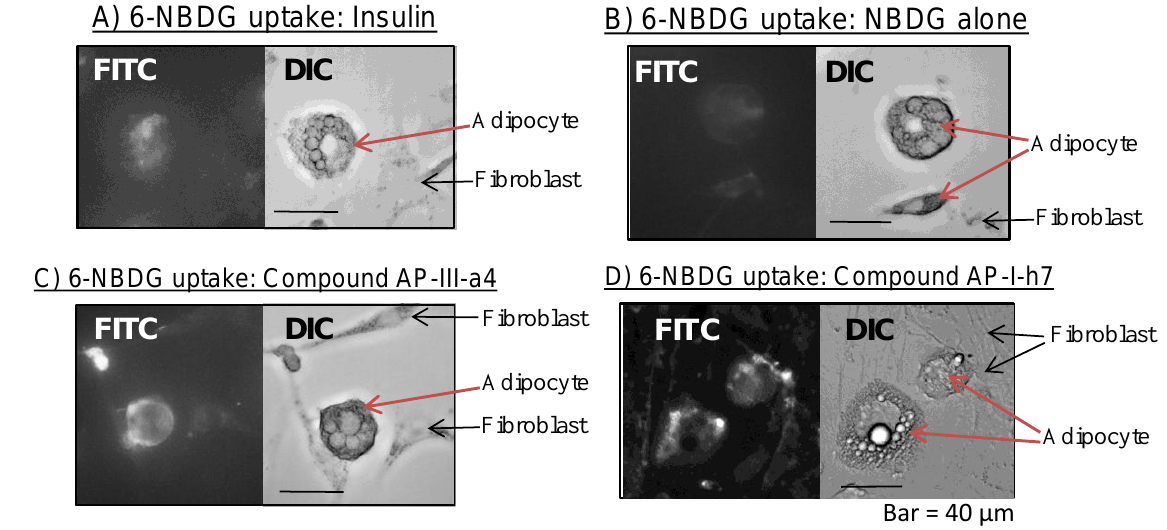
Figure 3. Data from our laboratory indicating that the fluorescent-tagged glucose probe, 6-NBDG, enters cells in response to insulin treatment. Two populations of cells were cultured together; fibroblasts and adipocytes, which can be distinguished under DIC microscopy by adipocyte-specific deposition of lipid droplets. ( A ) Adipocytes are insulin sensitive cells, unlike fibroblasts. In response to insulin treatment, adipocytes selectively take-up the NBDG probe (as shown by FITC fluorescence microscopy); ( B ) However, NBDG treatment without insulin produced markedly less NBDG uptake by the adipocytes; ( C , D ) Two new triazine-based insulin mimetic agents (termed AP-III-a4 and AP-I-h7) could also induce NBDG uptake selectively in adipocytes, suggesting that these compounds are attractive candidates for further development as diabetes drugs.